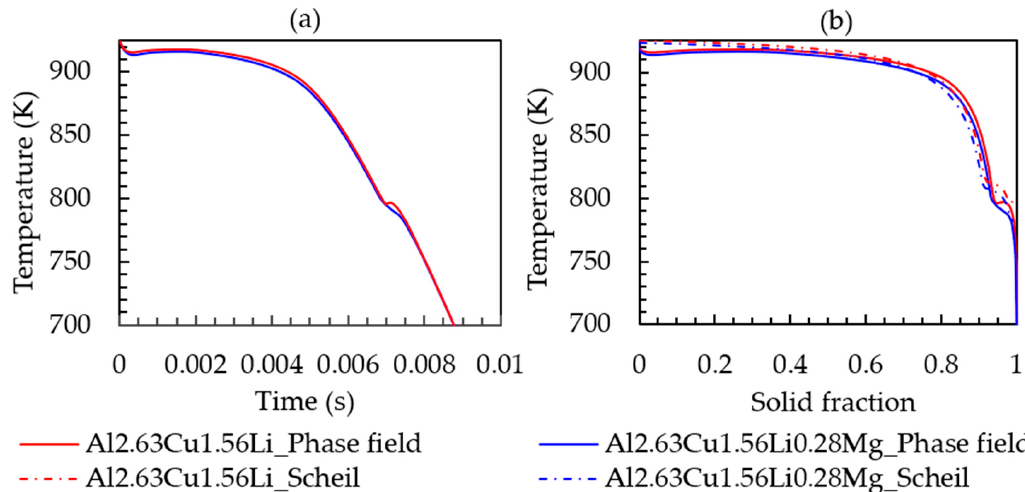
Figure 10. ( a ) Time ‐ temperature cooling curve; ( b ) solid fraction ‐ temperature curve of Al ‐ 2.63Cu ‐ 1.56Li and Al ‐ 2.63Cu ‐ 1.56Li ‐ 0.28Mg droplet solidification.